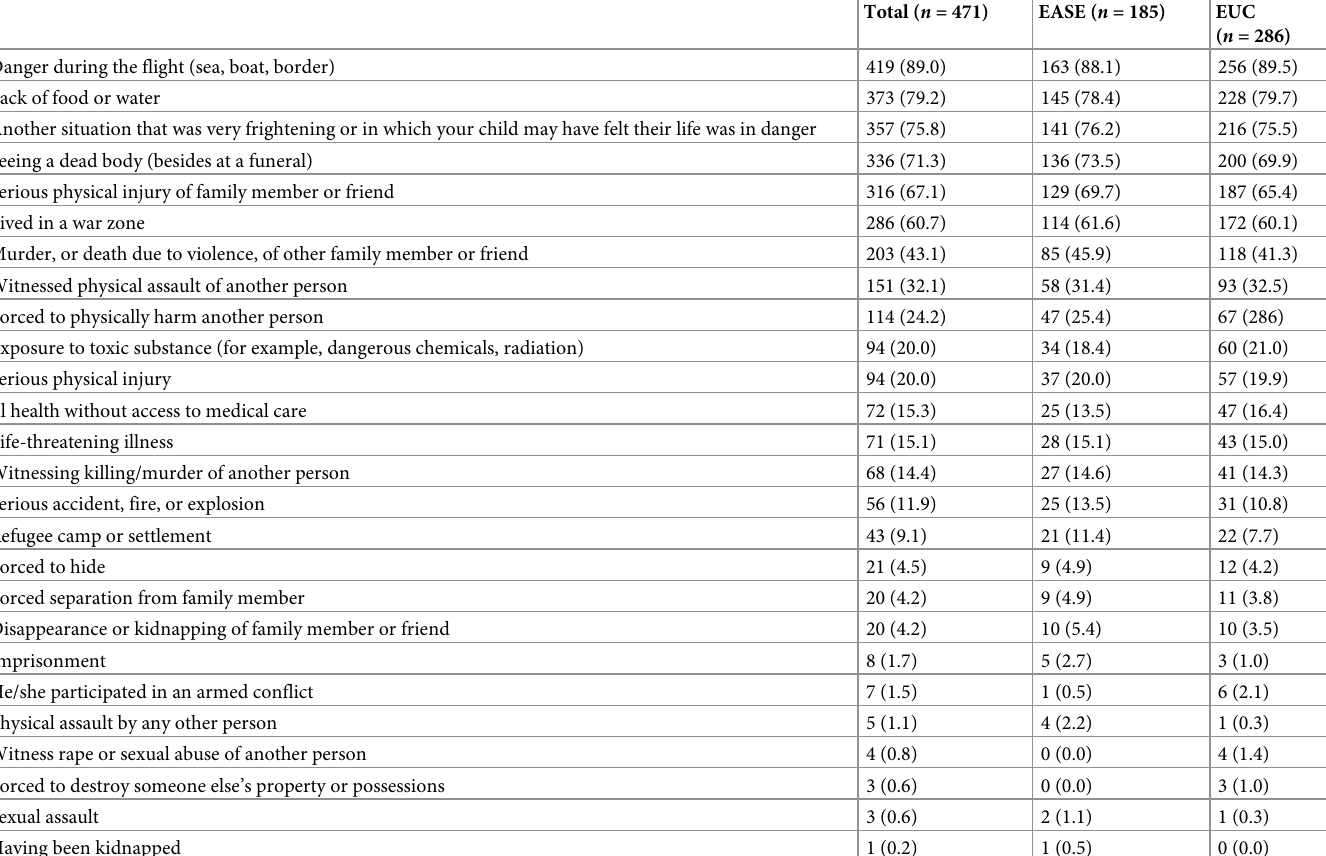
Table 2. Participants’ reported trauma